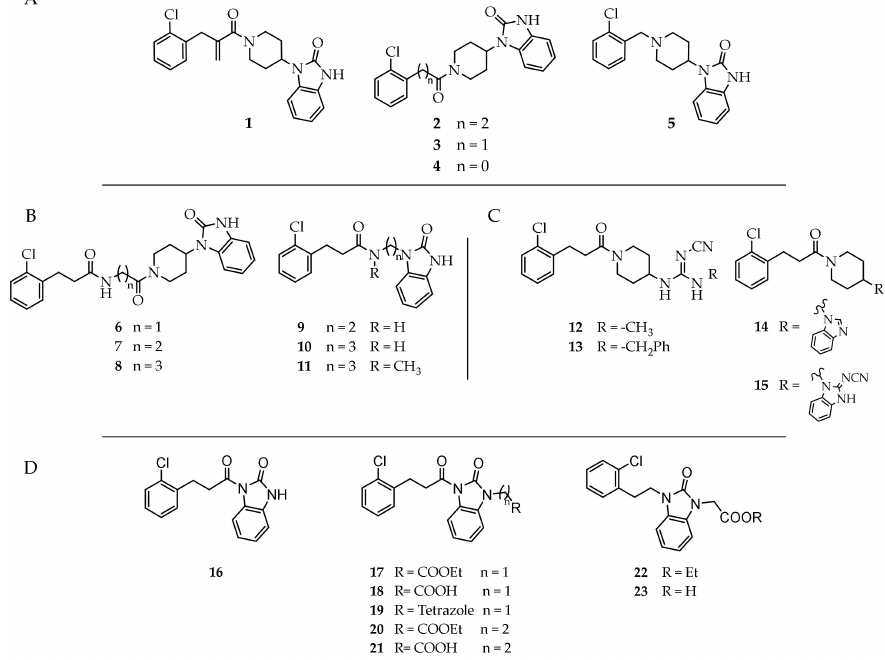
Figure 2. Chemical structures of synthesised compounds. ( A ) Modulation of the aliphatic chain linking the 2-chlorobenzene moiety to the piperidine ring ( 1 – 5 ); ( B ) Modulation of the amide substituent and of the benzoimidazol-2-one linker ( 6 – 11 ); ( C ) Replacement of the benzimidazol-2-one moiety with urea-like substructures ( 12 – 15 ); ( D ) Elimination of the piperidine ring and benzoimidazol-2-one functionalization ( 16 – 23